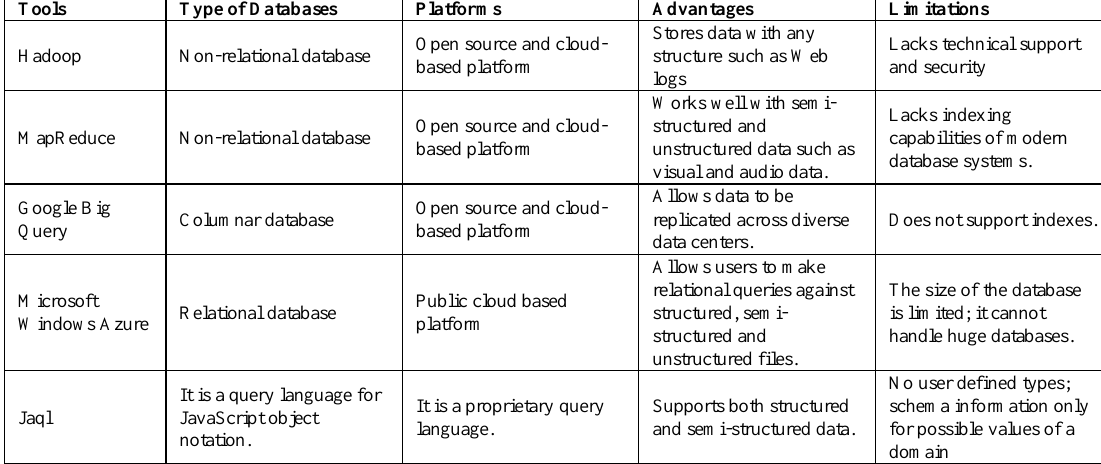
Table 6. A comparison of tools used for analyzing big data